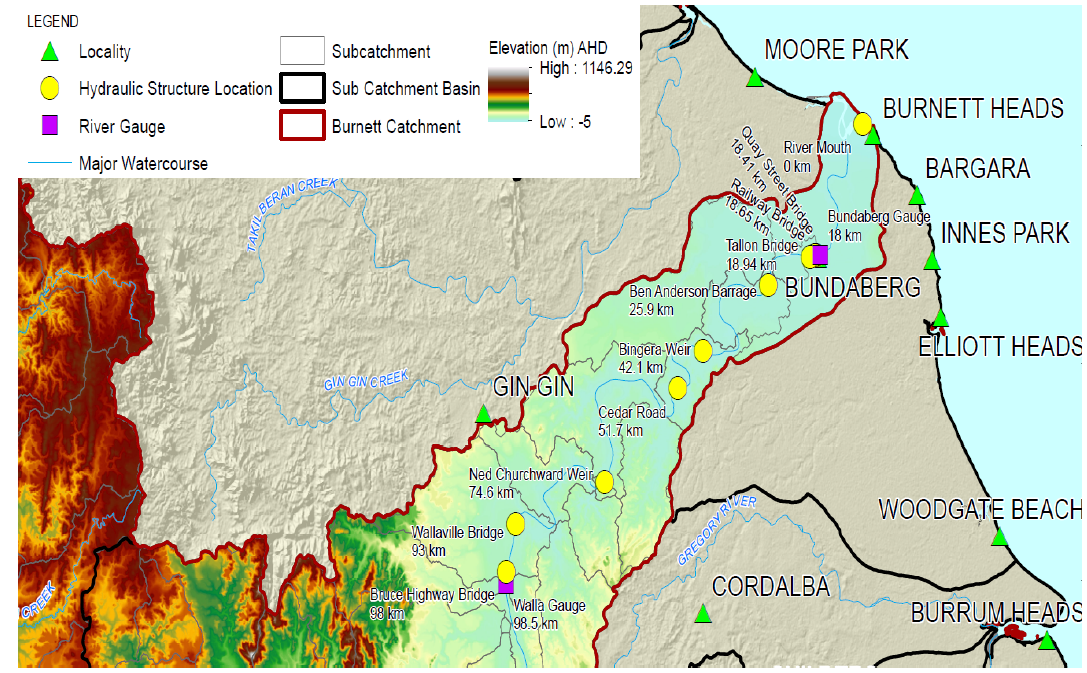
Figure 3. A part of the Burnett River catchment related to the area of the study [47].